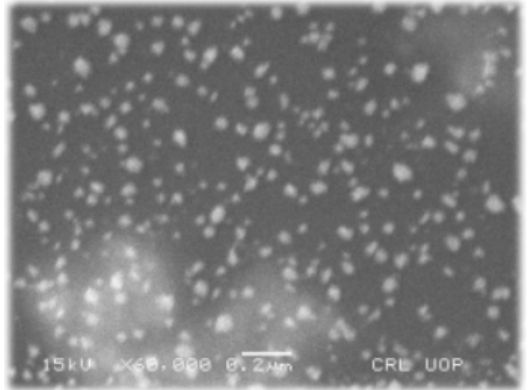
Fig. 5. SEM photomicrograph of nickel nanoparticles at 15 kv x 60,000